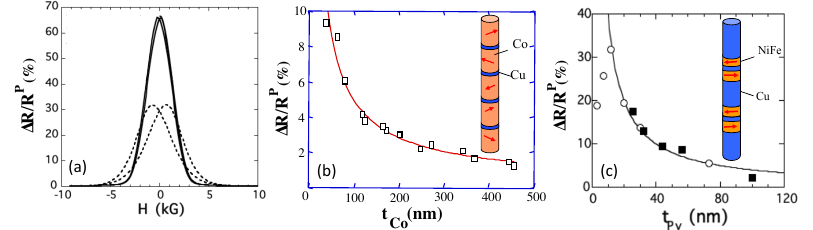
Figure 9. ( a ) CPP-GMR versus applied field parallel to the layers at 77 K for Py/Cu (full line) and Co/Cu (dashed line) multilayered nanowires; ( b , c ) GMR versus t FM at T = 77 K ( b ) for Co( t Co )/Cu(8 nm) multilayered nanowires and ( c ) for nanowires composed of [Py( t Py )/Cu(10 nm)/Py( t Py )] trilayers separated by 100 nm of Cu (open circles) or 500 nm of Cu (filled squares). The solid lines in ( b ) and ( c ) represent a variation as 1/ t FM (adapted from [5]). figure adapted from ref. [5] with permission of the